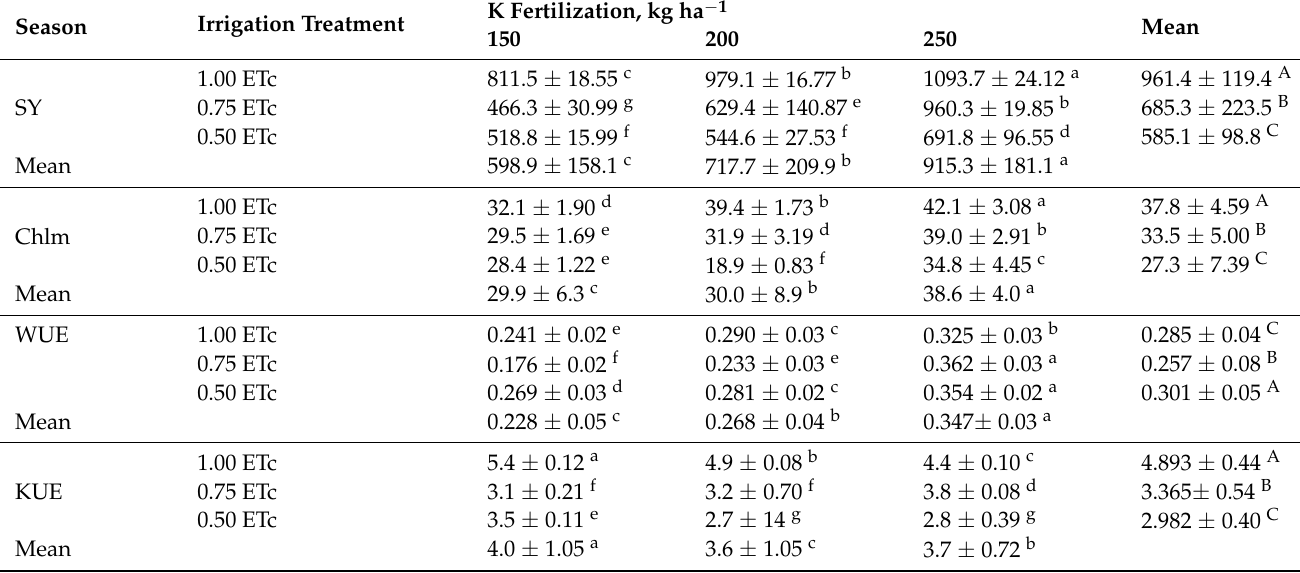
Table 4. Means and standard deviations of four parameters (potassium-use efficiency (KUE), chloro- phyll meter (Chlm), water-use efficiency (WUE), and seed yield (SY) under interaction effect of irrigation regime and potassium fertilization rate across spring and fall